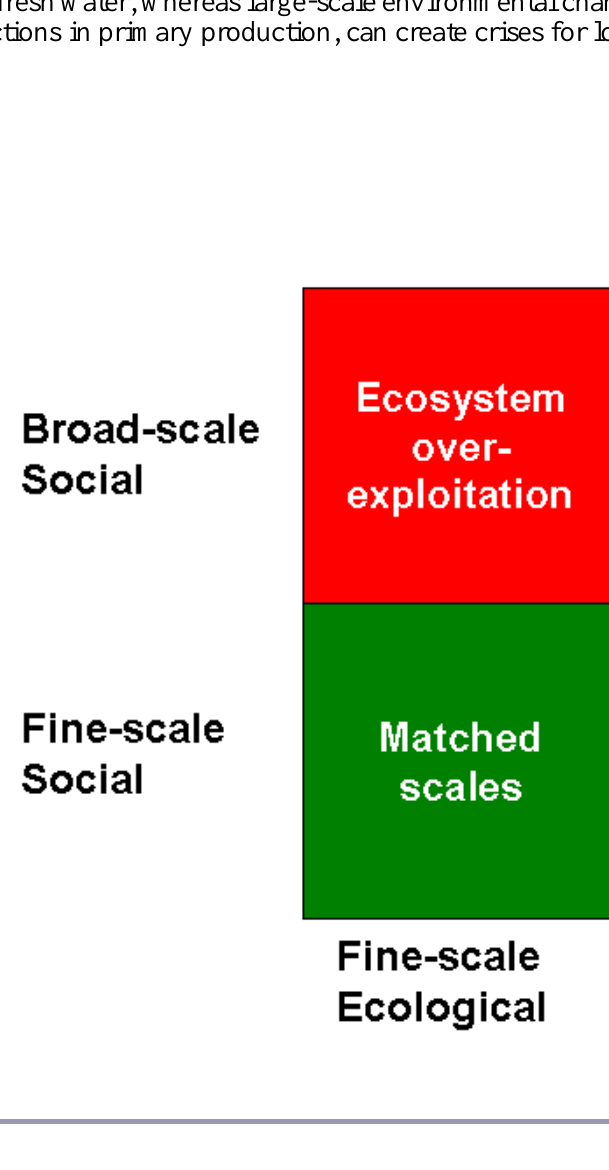
Fig. 3 .Consequences of mismatched functional scales (indicated in red) between social and ecological systems. For example, problems arise when a city grows beyond the ability of the ecosystem to provide it with fresh water, whereas large-scale environmental changes, such as rising sea levels or relatively sudden reductions in primary production, can create crises for local